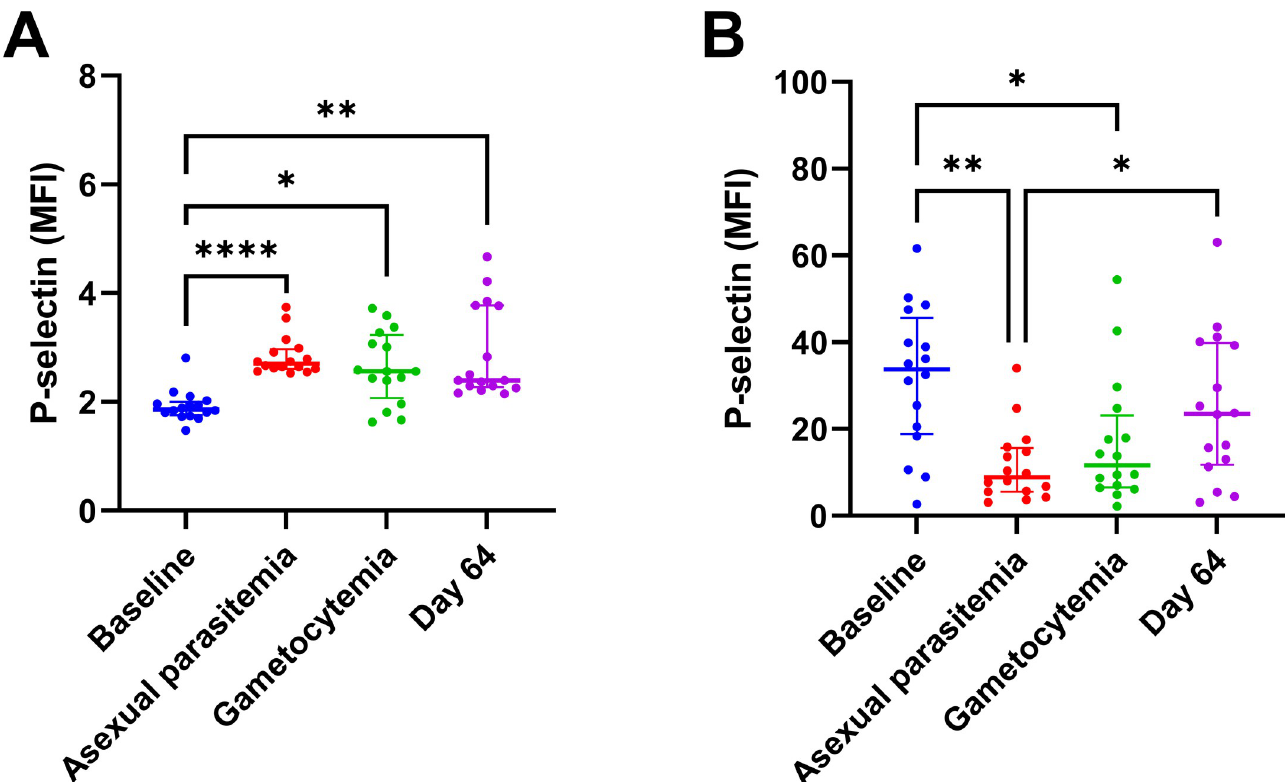
Fig 2. P-selectin expression in the four stages of plasmodium falciparum infection. (A) and platelets stimulated with CRP (B). (A) P-selection expression measured in unstimulated platelets was significantly increased at the time of asexual parasitemia, gametocytemia and convalescence compared to baseline. (B) P- selection expression measured in CRP-stimulated platelets was significantly decreased at the time of asexual parasitemia, gametocytemia and convalescence compared to baseline. Results are shown as the median and interquartile range, and � , �� , and ���� indicate p-values below 0.05, 0.01, and 0.0001, respectively.